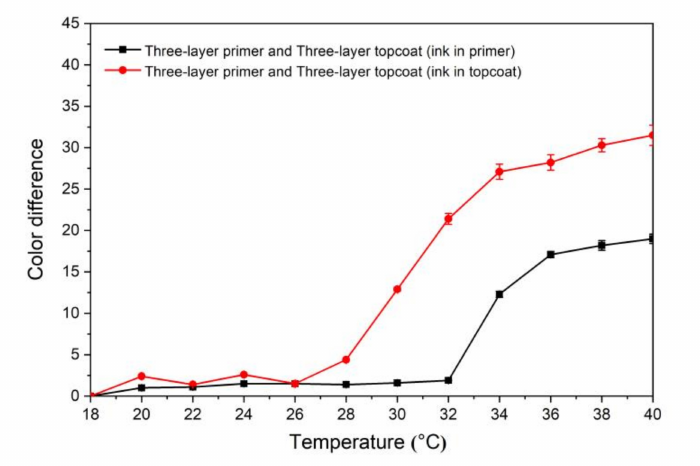
Figure 7. Change of color di ff erence of waterborne coating on Chinese fir surface at warming-up.